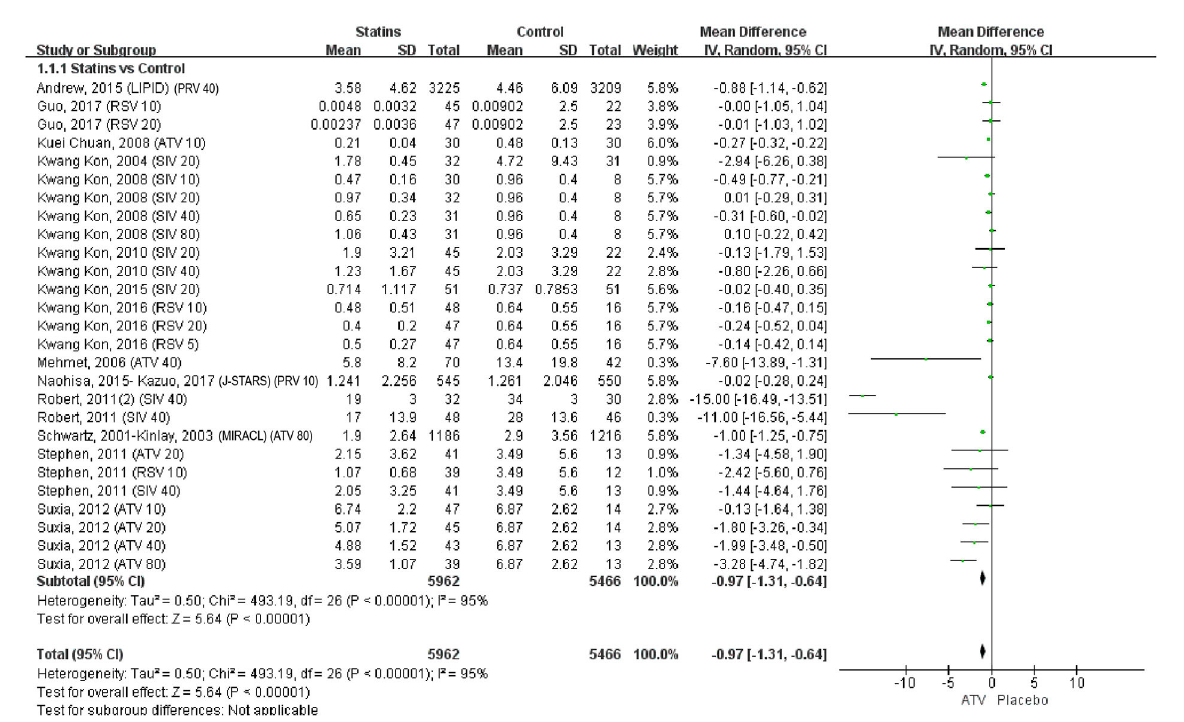
FIGURE3 Forest plot of pairwise meta-analysis between statins and control. Note: PRV 40: Pravastatin 40 mg/d; RSV 10: Rosuvastatin 10 mg/d; Rosuvastatin 20 mg/d; ATV 10: Atorvastatin 10 mg/d; SIV 20: Simvastatin 20 mg/d; SIV 10: Simvastatin 10 mg/d; SIV 40: Simvastatin 40 mg/d; SIV 80: Simvastatin 80 mg/d; RSV 5: Rosuvastatin 5 mg/d; ATV 40: Atorvastatin 40 mg/d; PRV 10: Pravastatin 10 mg/d; ATV 80: Atorvastatin 80 mg/d; ATV 20: Atorvastatin 20 mg/d.